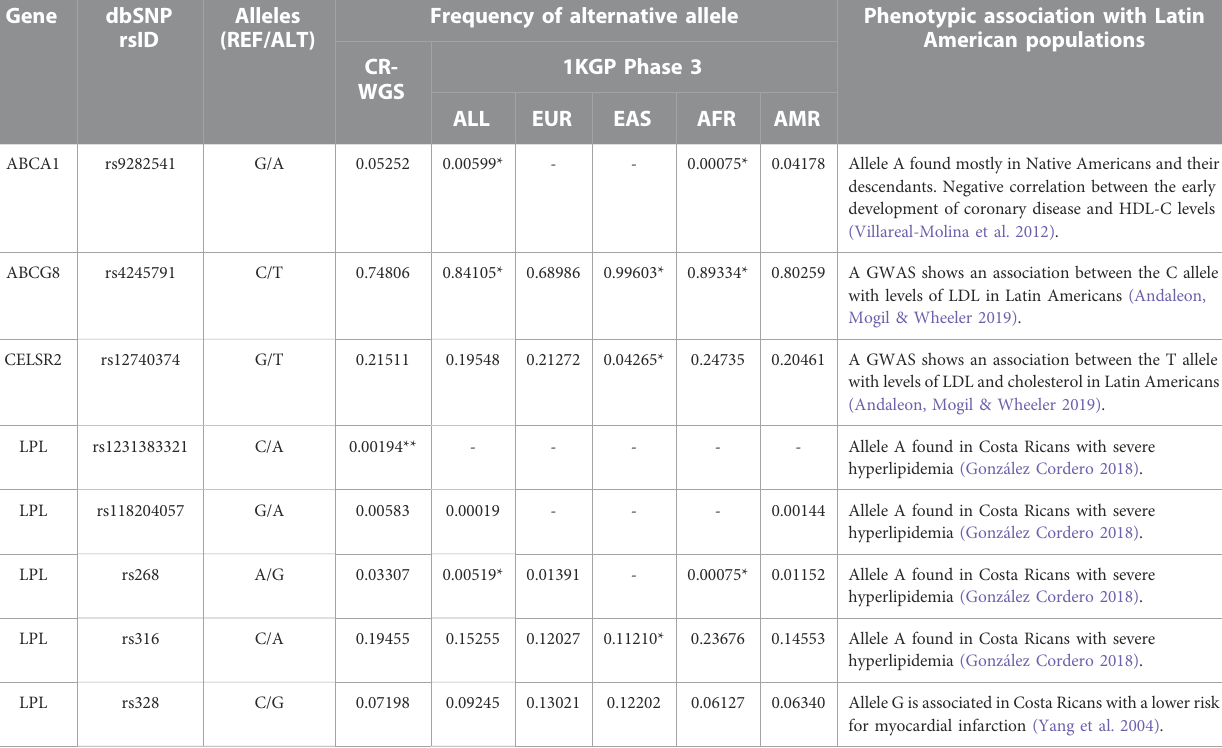
TABLE 6 Variants previously reported in genes involved in lipid metabolism from Costa Rica and Latin America. CR-WGS: Costa Rican genomes evaluated in this study, ALL: all Subjects from 1KGP phase 3, EAS: East Asia, EUR: Europe, AFR: Africa, AMR: Latin America. * Signi fi cantly different allelic frequency ( p < 0.05) compared to CR-WGS. ** Found in one